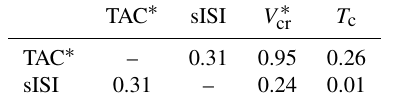
are also related to ice sheet changes. Models for Greenland little difference to the present. Using on ice sheet modeling,